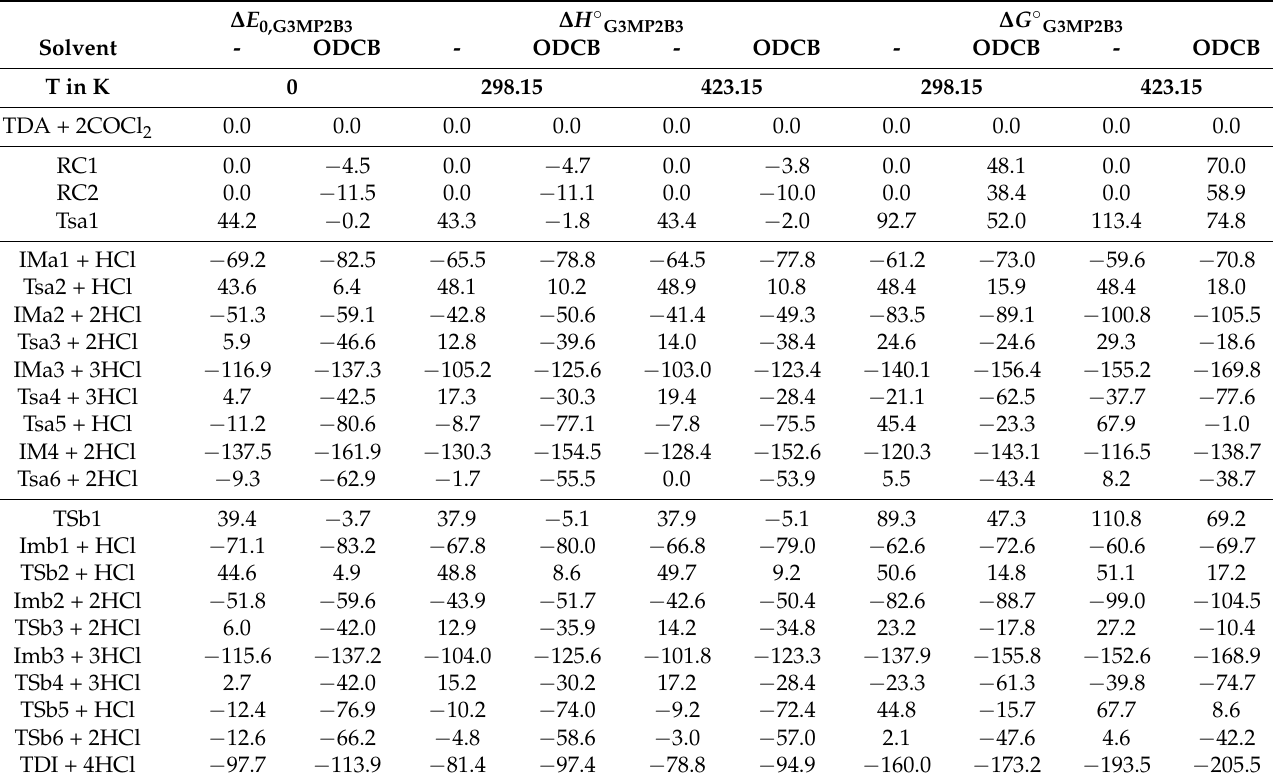
Table 1. G3MP2B3 thermochemical properties calculated in the gas phase and ortho-dichloroben-